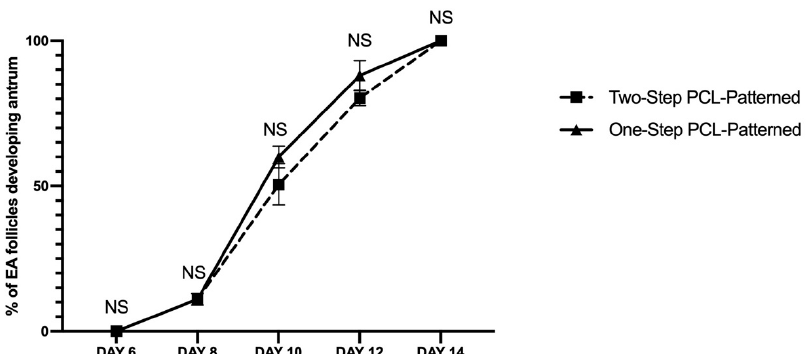
Figure 11. Development trend of the follicular antrum over time according to follicular treatment groups. A total of 120 and 120 follicles were cultured in three independent experiments during which Two-Step PCL-Patterned and One-step PCL-Patterned electrospun scaffolds were simultaneal compared (Two-Step PCL-Patterned: 40, 40, and 40 PA follicles per experiment; One-Step PCL-Patterned: 40, 40, and 40 PA follicles per experiment). Specifically, only follicles that differentiated the follicular antrum during ivF cultures, were tested (97 and 98 EA follicles, respectively, for Two-Step PCL-Patterned and One-Step PCL-Patterned). NS: not statistically significant.